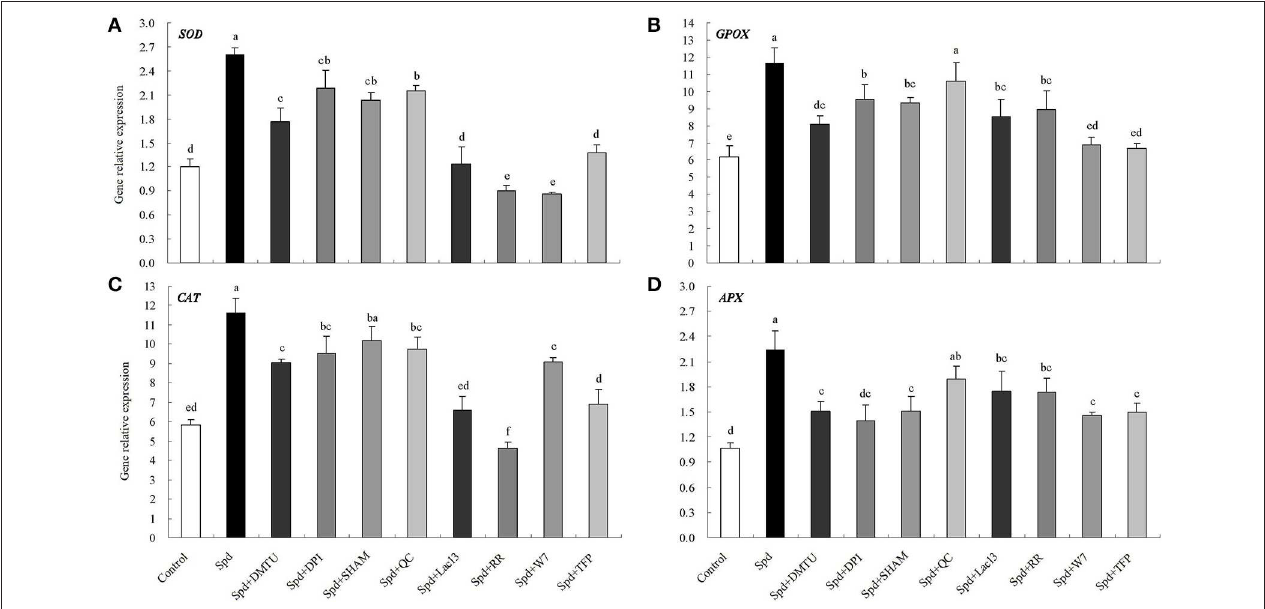
FIGURE 12 | Spd-induced SOD (A), GPOX (B), CAT (C), and APX (D) gene transcript levels were dependent on hydrogen peroxide (H 2 O 2 ) signaling and calcium (Ca 2 + ) messenger system. The detached leaves of white clover were pre-treated with distilled water for 1h to eliminate wound stress and then treated for 2h as follows: 1, distilled water (control); 2, 20 µ M Spd; 3, 20 µ M Spd + 5mM dimethylthiourea (DMTU); 4, 20 µ M Spd + 100 µ M Diphenyleneiodonium (DPI); 5, 20 µ M Spd + 5mM salicyhydroxamic (SHAM); 6, 20 µ M Spd + 100 µ M quinacrine (QC); 7, 20 µ M Spd + 1mM LaCl 3 ; 8, 20 µ M Spd + 50 µ M ruthenium red (RR); 9, 20 µ M Spd + 150 µ M N-(6-Aminohexyl)-5-chloro-1-naphthalenesulfonamide (W7); 10, 20 µ M Spd + 30 µ M trifluoperazine (TFP). Means of four independent samples are presented. Bars represent standard errors. The same letter indicates no significant difference (LSD) at P <